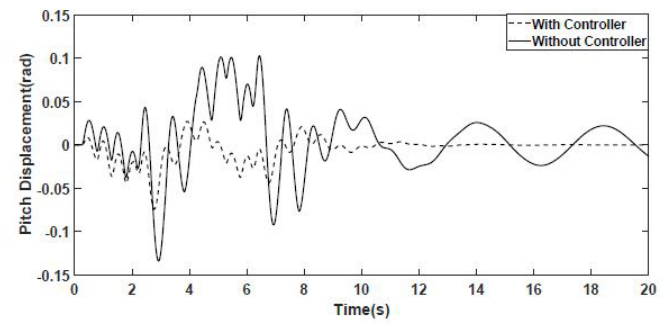
Figure 15. Vertical Displacement PN.